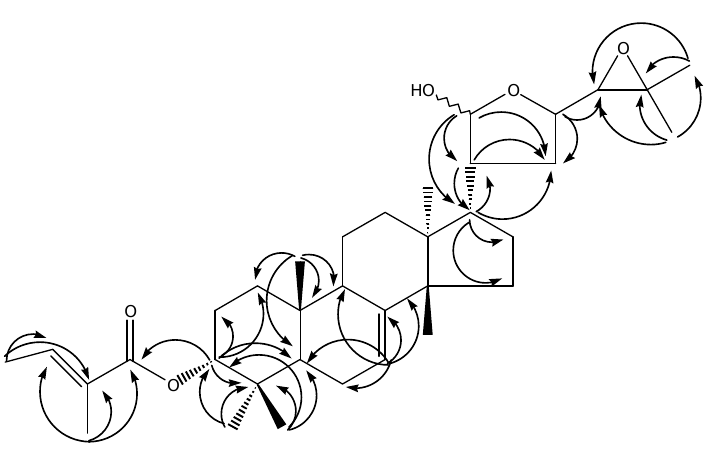
Figure 2. Key HMBC correlations (H → C) of compound 1 .